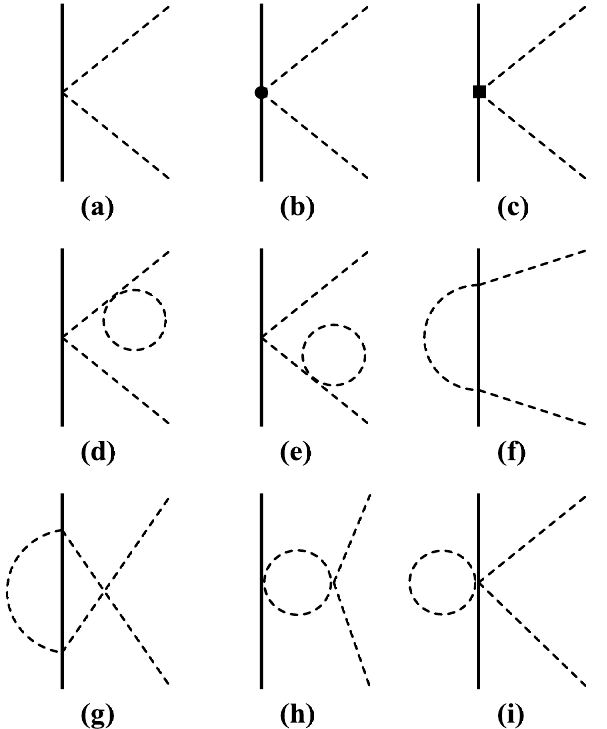
Fig. 1 Tree and nonvanishing loop diagrams in the calculation of the Goldstone-heavy meson scattering amplitudes to the third order in HMChPT. The dashed lines represent the Goldstone bosons and solid lines represent the pseudoscalar heavy mesons. The heavy dots and filled squares refer to the vertices from L